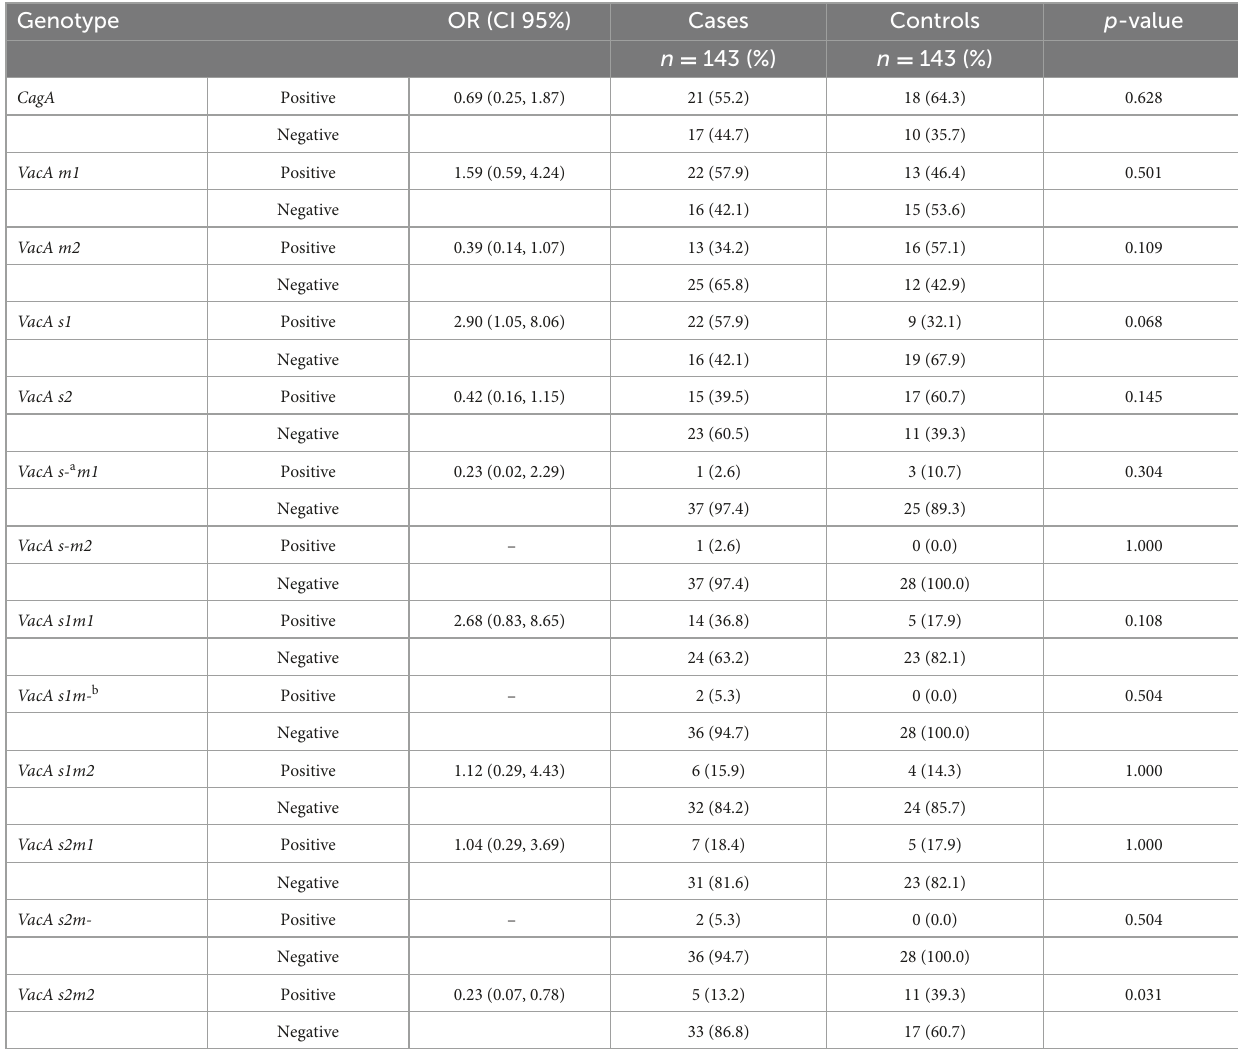
TABLE 3 Detection and distribution of H. pylori virulence genes in cases and controls. Genotype OR (CI 95%)